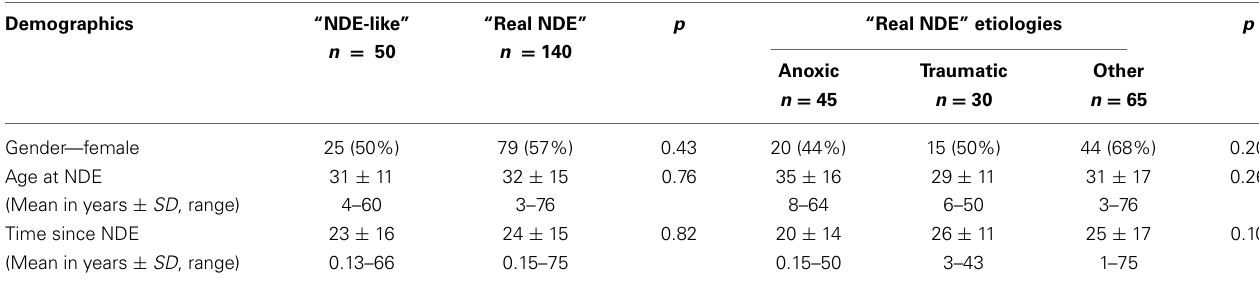
Table 1 | NDErs demographic characteristics ( N = 190).